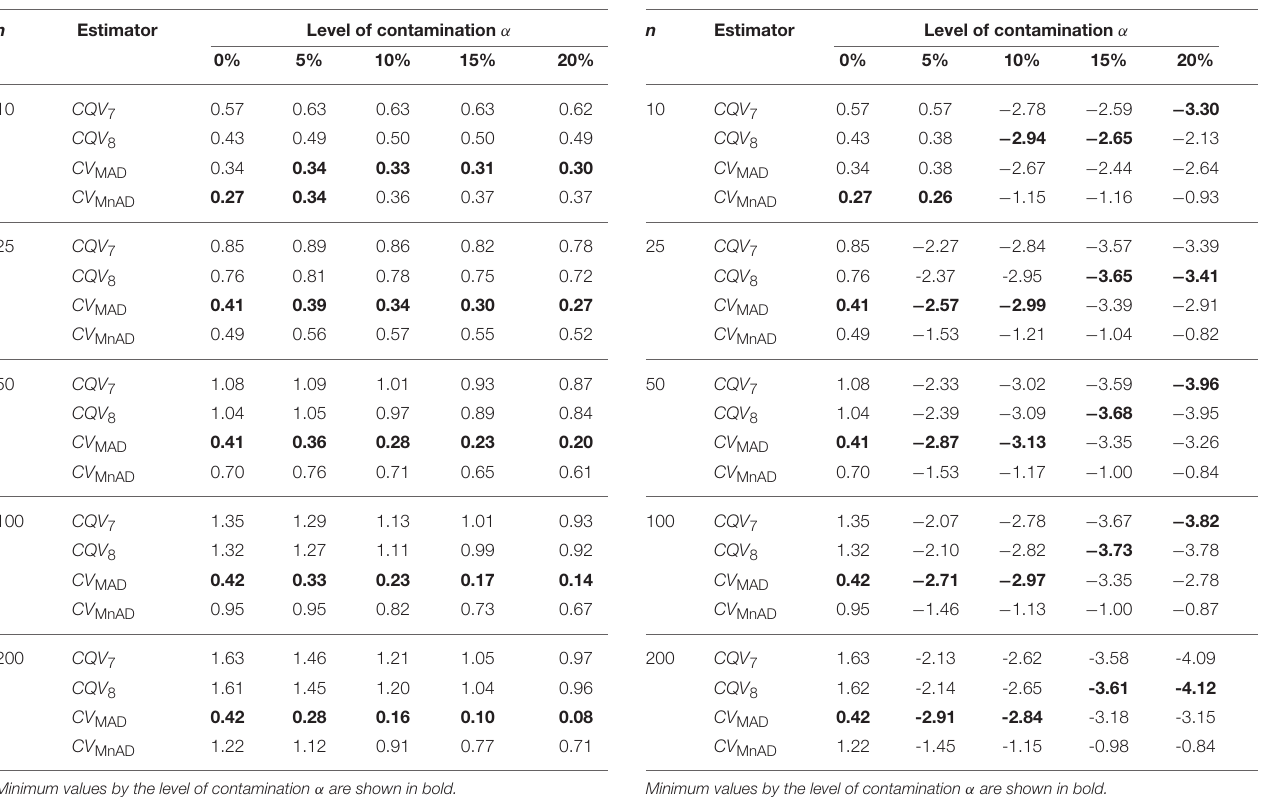
TABLE 4 | Median values of log 10 ( γ ) accuracy metric across θ produced for each estimator and sample sizes under the contaminated normal distribution HN t ( µ , σ , α , ν ) with heavy tails.